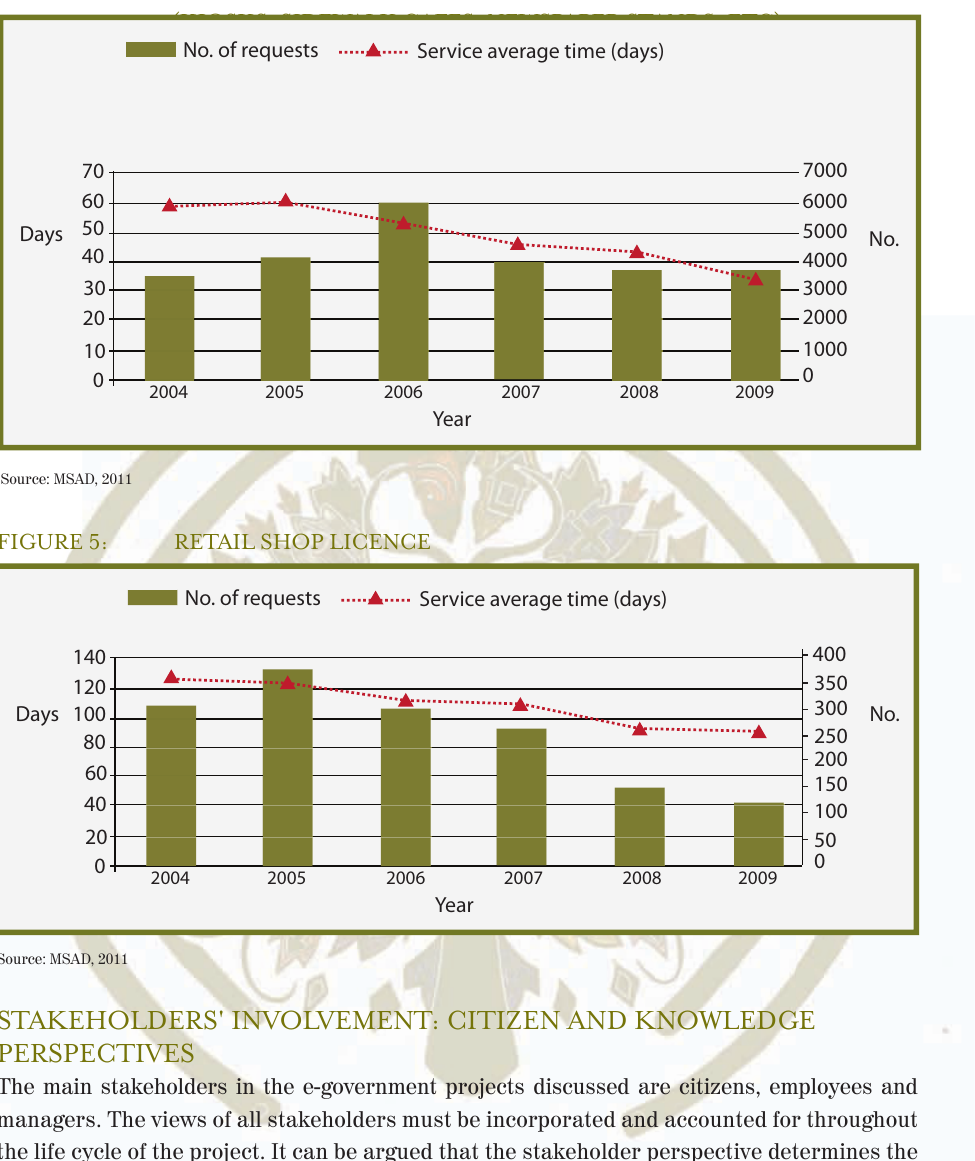
FIGURE 4: STREET OCCUPATION PERMIT (KIOSKS, SIDEWALK CAFES, NEWSPAPER STANDS, ETC)